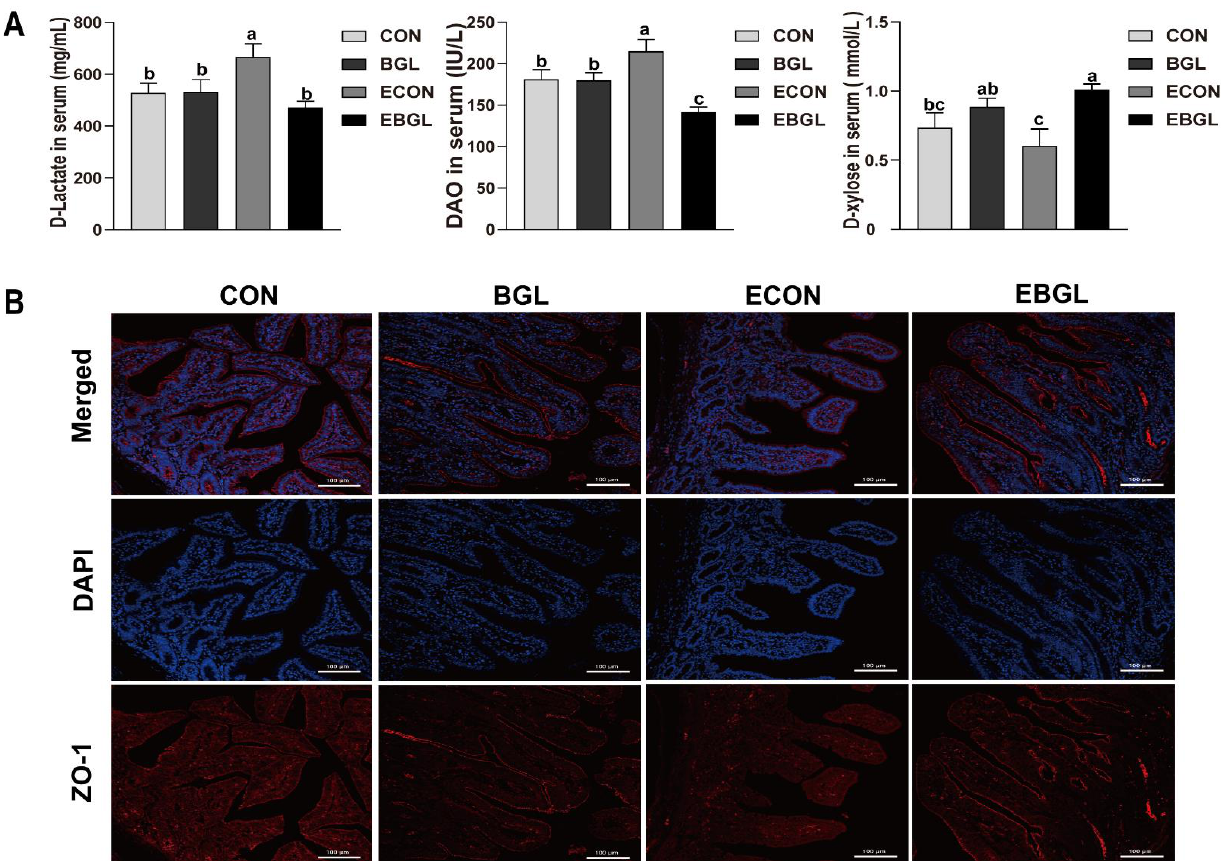
Figure 1. Effect of BGL on intestinal permeability ( A ) and distribution of ZO-1 protein ( B ) in weaned pigs upon ETEC challenge Zonula occludens 1, ZO-1; 4’-6-diamidino-2-phenylindole, DAPI. ZO-1 protein (red), DAPI stain (blue), and merged ZO-1 protein and DAPI are shown. a, b, c, values within a row with different superscript letters are significantly different ( p < 0.05). CON, pigs were fed with a basal diet; BGL, pigs were fed with a BGL-containing diet (500 mg/kg); ECON, pigs were fed with a basal diet and challenged by ETEC; EBGL, pigs were fed with a BGL-containing diet (500 mg/kg) and challenged by ETEC.